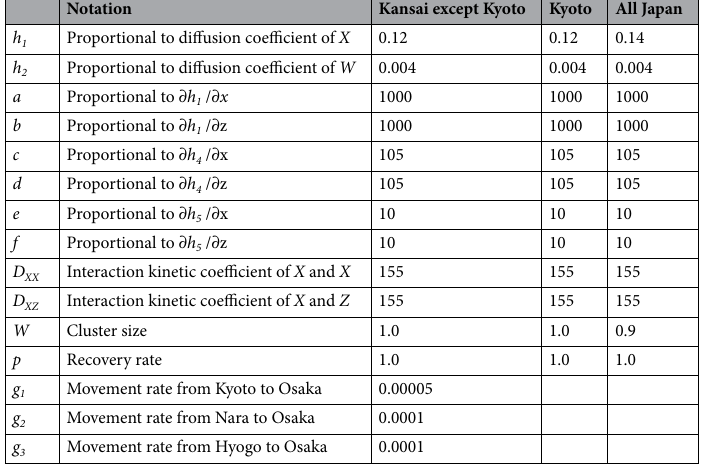
Table 1. Parameters for simulation.